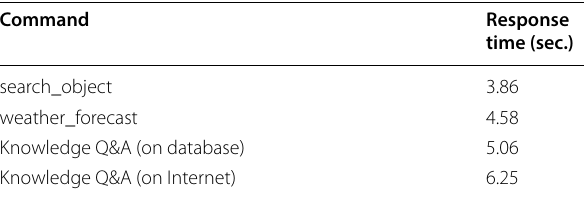
Table 4 Average of response time after the commands are